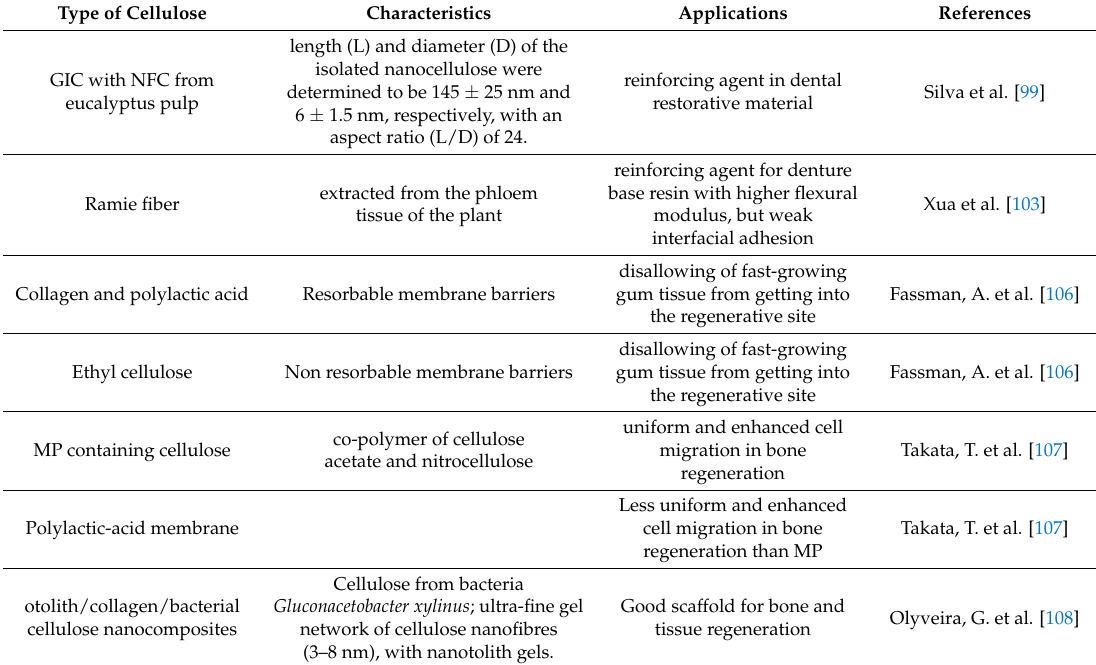
Table 5. Summary of the cellulose-based materials tested in dental